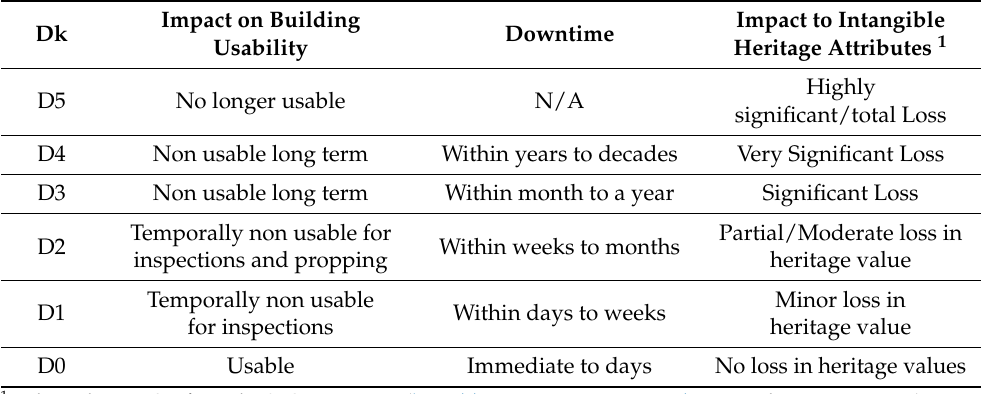
Table 6. Possible correlation between earthquake-induced physical Damage level, residual building usability and downtime, and long-term impact on intangible heritage attribute. Impact to Intangible Impact on Building Downtime Dk Heritage Attributes 1 Usability Highly D5 No longer usable N/A significant/total Loss D4 Non usable long term Within years to decades Very Significant Loss D3 Non usable long term Within month to a year Significant Loss Partial/Moderate loss in Temporally non usable for Within weeks to months D2 heritage value inspections and propping Minor loss in Temporally non usable Within days to weeks D1 heritage value for inspections D0 Usable Immediate to days No loss in heritage